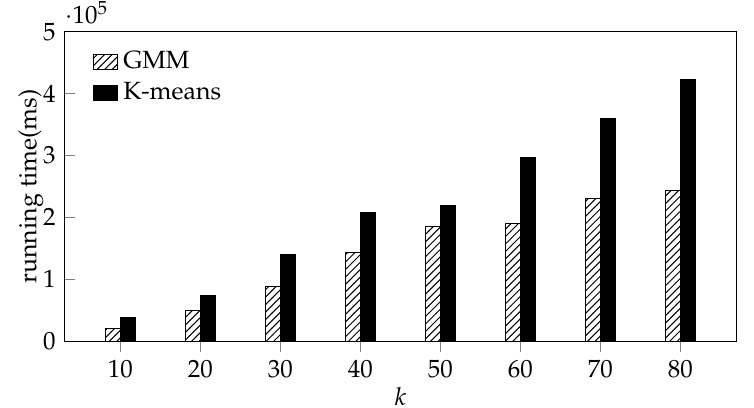
Figure 9. Efficiency comparison between K-means and GMM ( k ∈ { 10, . . . ,80 }